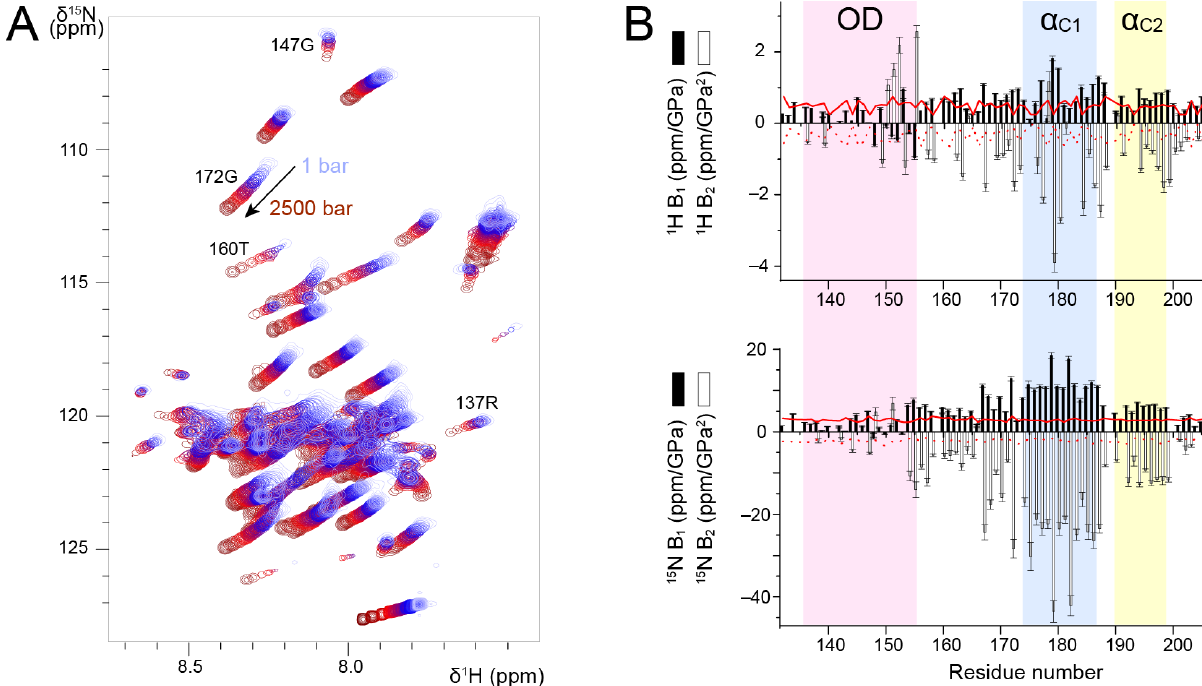
Figure 4. Discrimination between stably associated and isolated helices in RSV P 127–205 by variable pressure NMR experiments. ( A ) Overlay of 1 H- 15 N HSQC spectra of P 127–205 acquired by increasing pressure from 1 to 2500 bar. NMR data were recorded at 600 MHz 1 H Larmor frequency. The temperature was 313 K. ( B ) First and second order pressure coefficients, B 1 and B 2 , were determined by fitting 1 H and 15 N chemical shift variations as a function of pressure to a second-order polynomial according to δ (P) − δ (P 0 ) = B 1 × (P − P 0 ) + B 2 × (P − P 0 ) 2 , and plotted with bar diagrams. Reference values for random coil conformation (taken from [60] ) were plotted as red lines (B 1 , solid line) and (B 2 , dotted line).